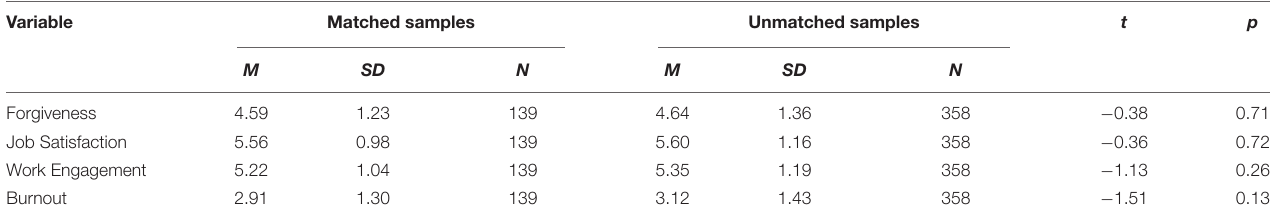
TABLE TA1 | Differences between matched samples and unmatched samples.